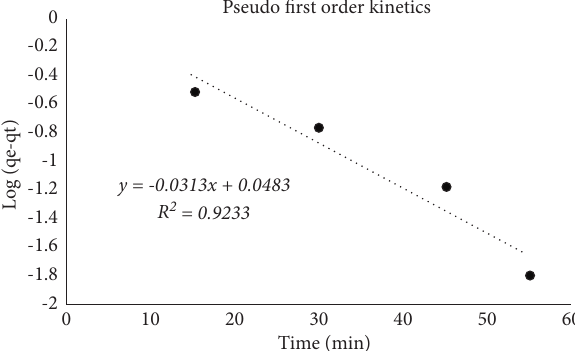
Figure 14: Pseudo-first-order kinetic for TT powder.